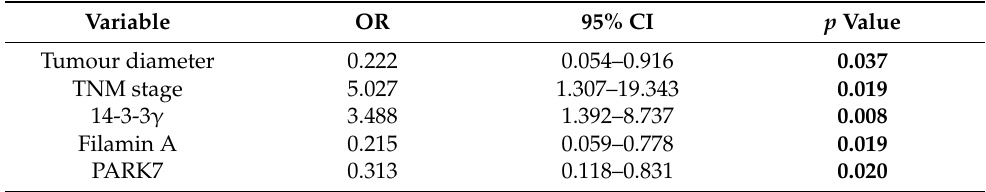
Table 4. Binary logistic regression for the relationship between the analyzed protein expression and clinicopathological characteristics with RTI.